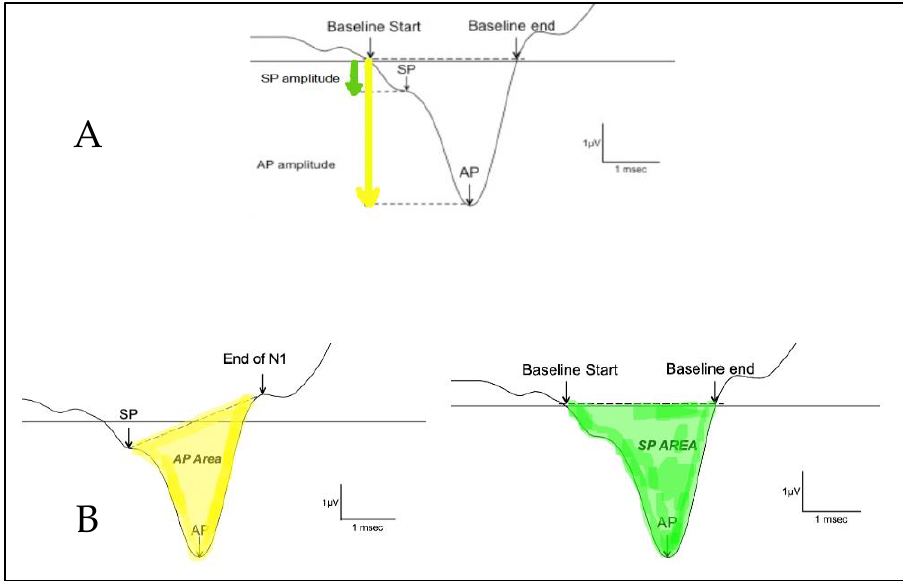
Figure 1. Calculation of the SP/AP ratio. ( A ) shows the amplitude and ( B ) shows the area under the curve. The AP area under the curve is defined as the area between the SP peak and the end of N1. The SP area under the curve is defined as the area between where the baseline starts and where the baseline ends.